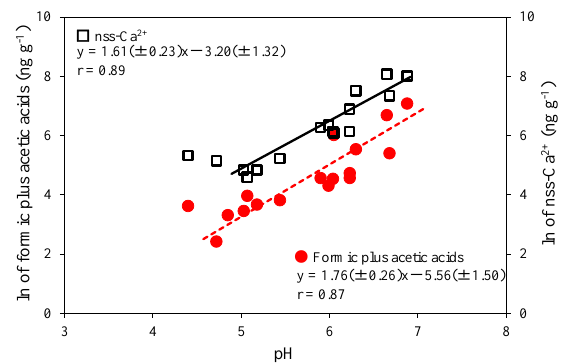
Figure 6. Scatter plots of the natural logarithm of formic plus acetic acids and pH, and natural the logarithm of nss–Ca 2 + and pH. The solid and dotted lines represent the Deming linear regression.